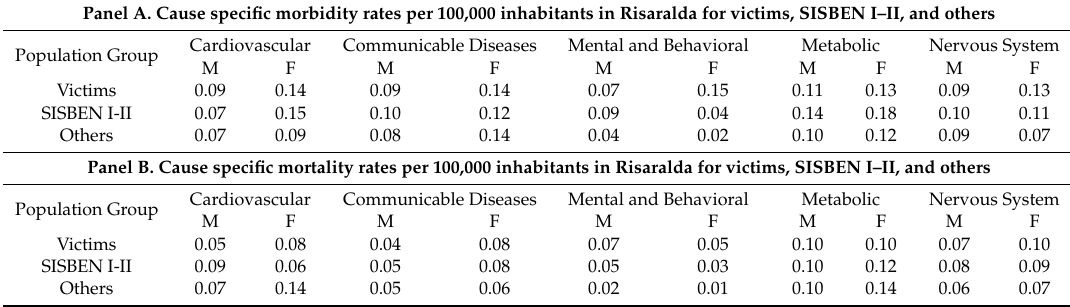
Table 1. Morbidity and mortality rates in Risaralda, 2011–2016.